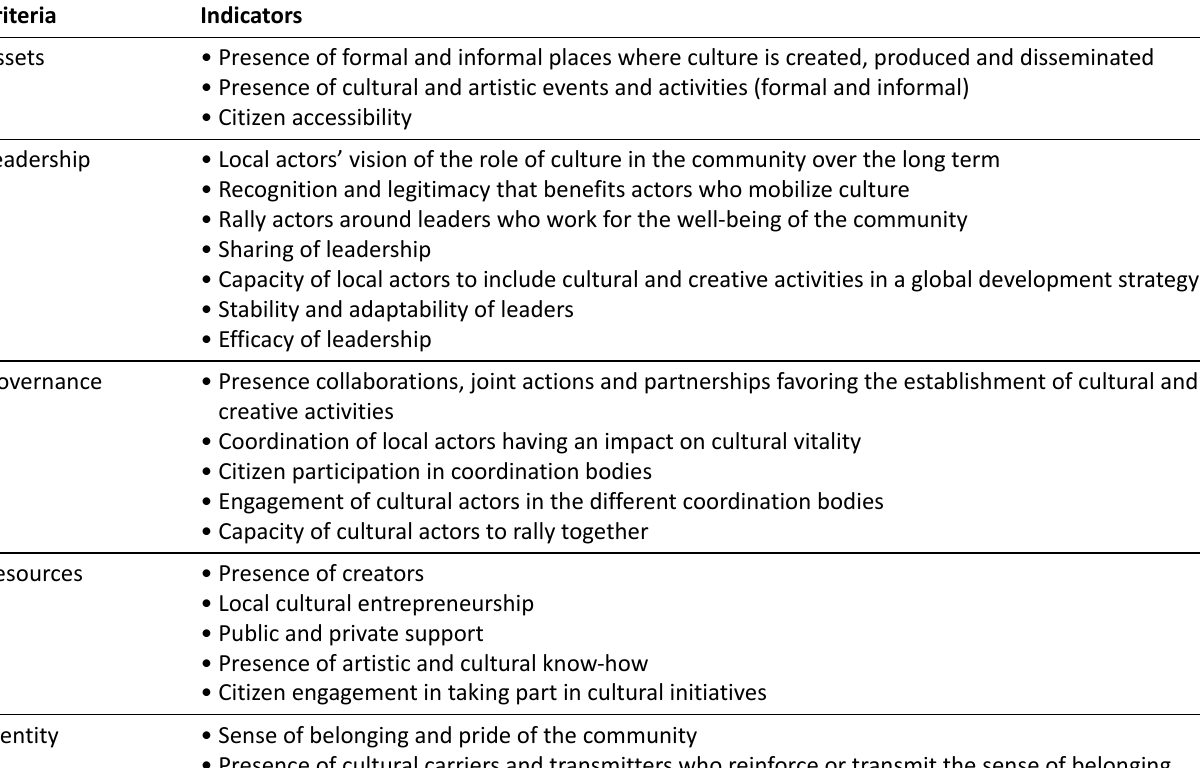
Table 1. Criteria and indicators of neighborhood cultural vitality. Source: own